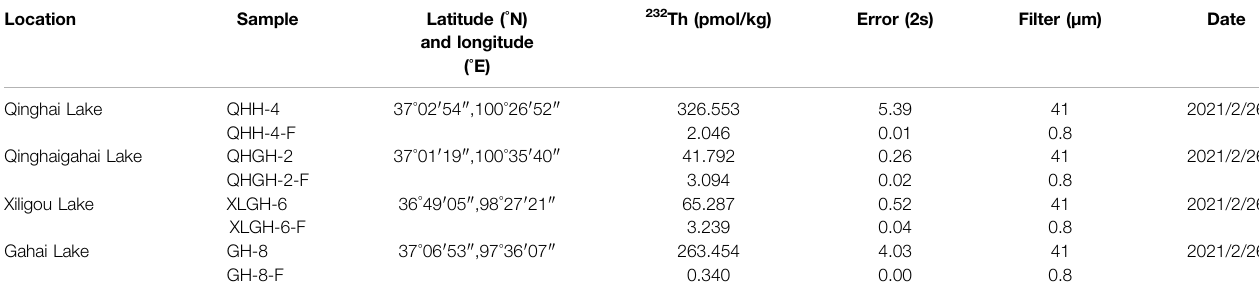
TABLE 2 | 232 Th concentration of samples fi ltered by 41- μ m and 0.8- μ m fi lters from several lakes in the Qaidam Basin. Location Sample Latitude ( ° N) and